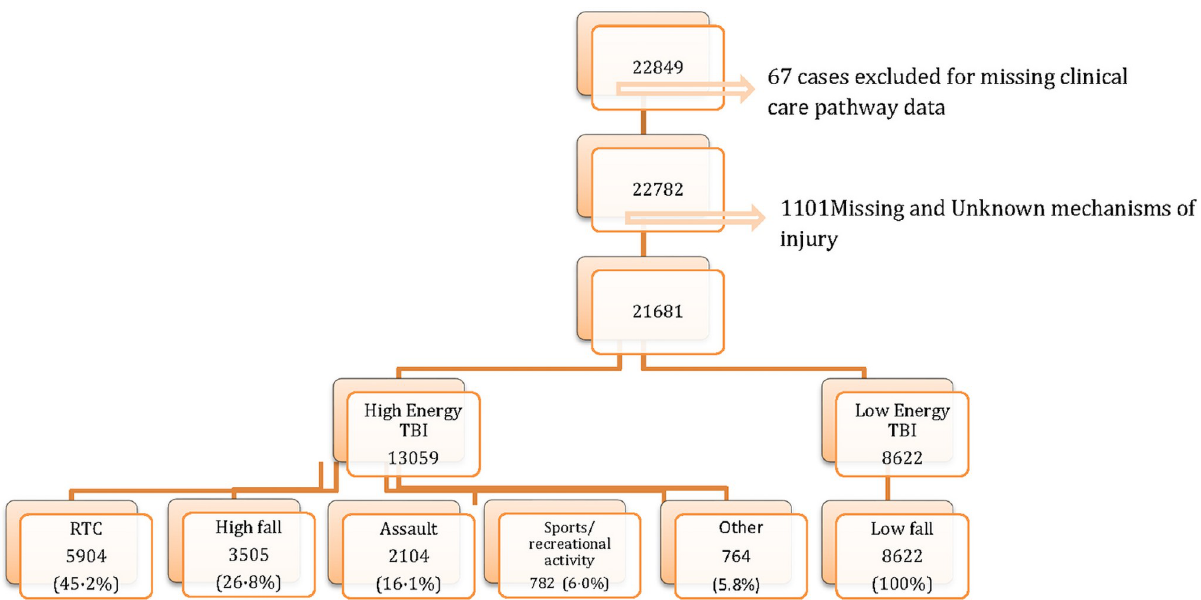
Fig 1. Identification of patients injured by high- and low-energy transfer. RTC, road traffic collision; TBI, traumatic brain injury.